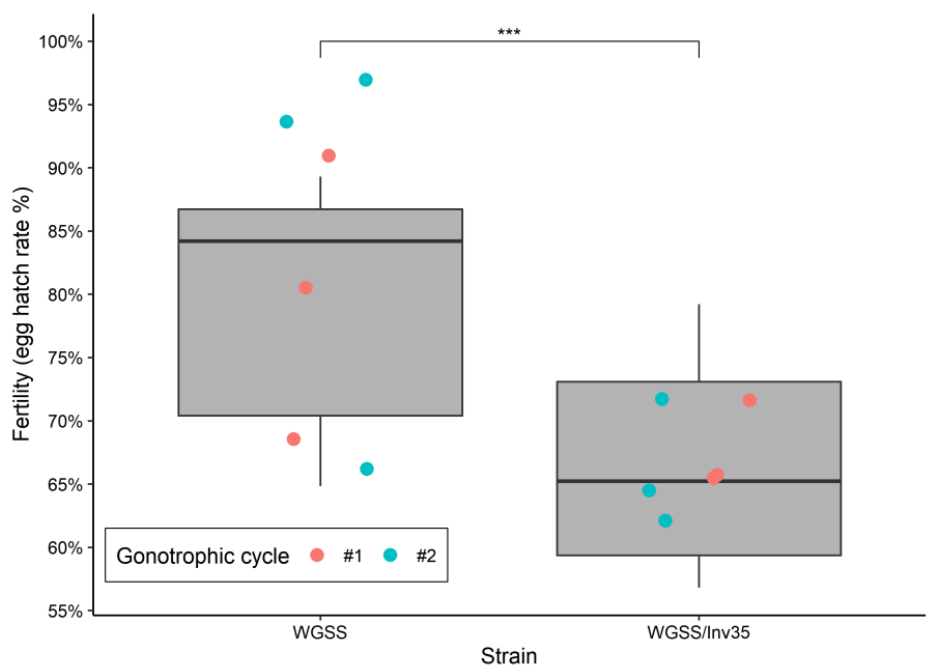
Figure 3. Fertility (100% × no. L1 larvae/total no. eggs) of WGSS and WGSS/Inv35. Three replicates were performed per gonotrophic cycle per strain. Statistical analysis was carried out using a GLM with binomial distribution and showed significant difference between the strains. The whiskers indicate the variability outside the upper and lower quartiles (represented as the upper and lower boxes, respectively). The thick horizontal line represents the median and the triangles indicate a possible outlier. Significance symbol: ‘***’ p value lower than 0.001.